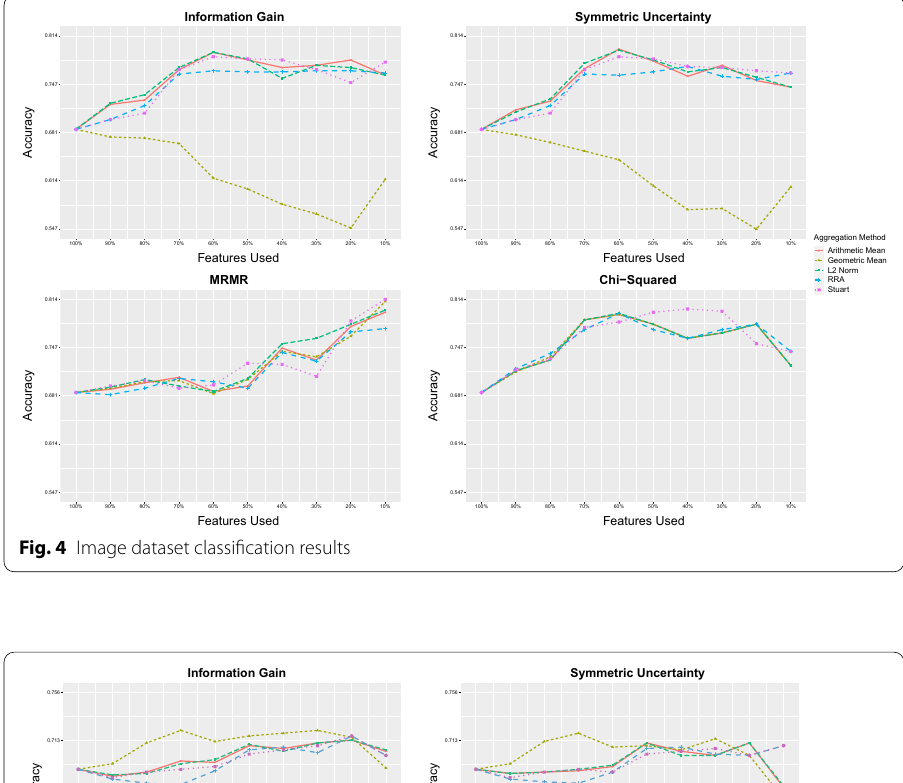
Fig. 4 Image dataset classification results